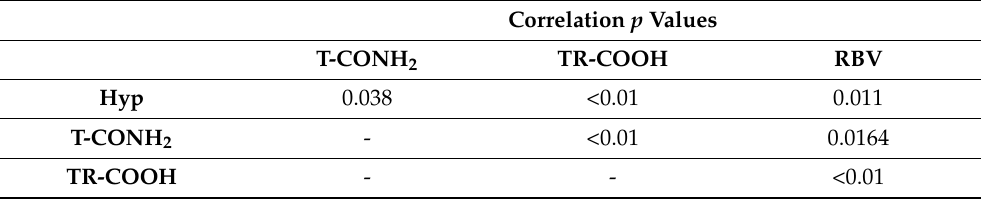
Table 4. Significant p values reported according to Spearman correlations for EOT patients ( n =